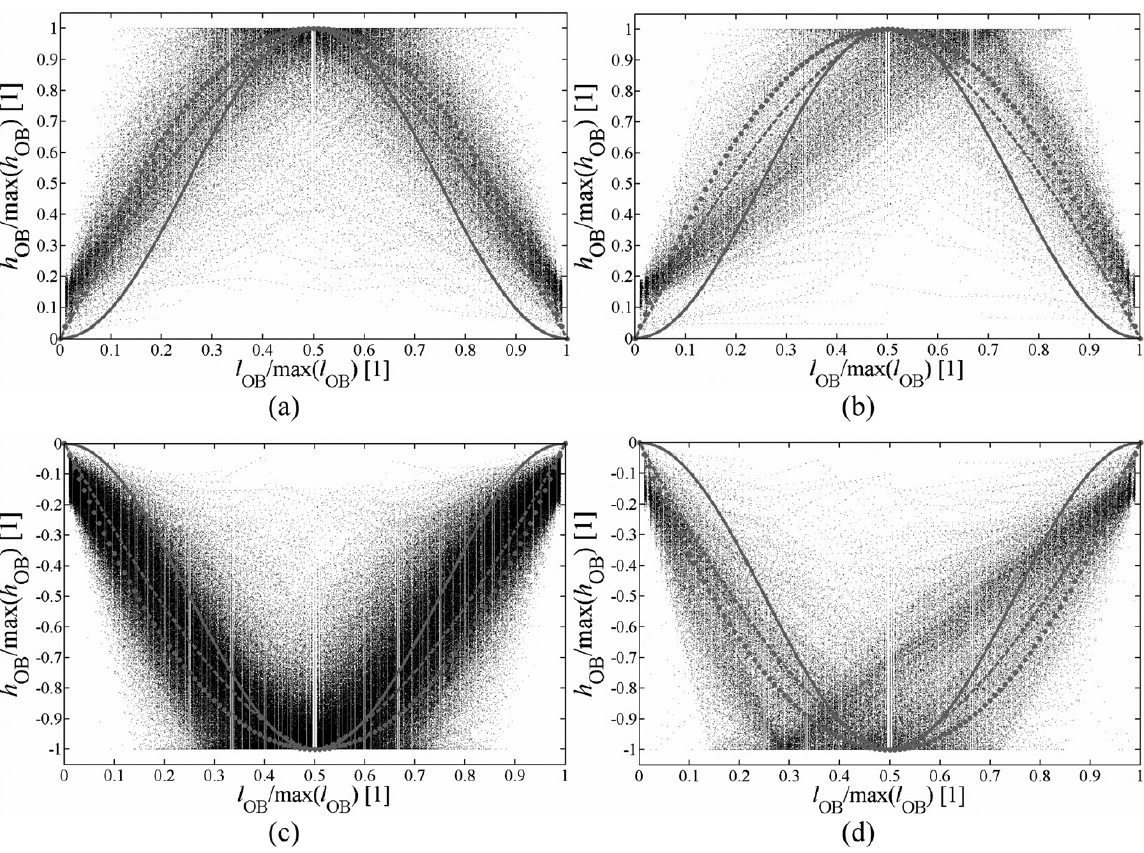
Fig. 3. Visual comparison of normalized empirical obstacles ( · · · ) with some analytical fi tting functions (cos ( ), power(1.5) (